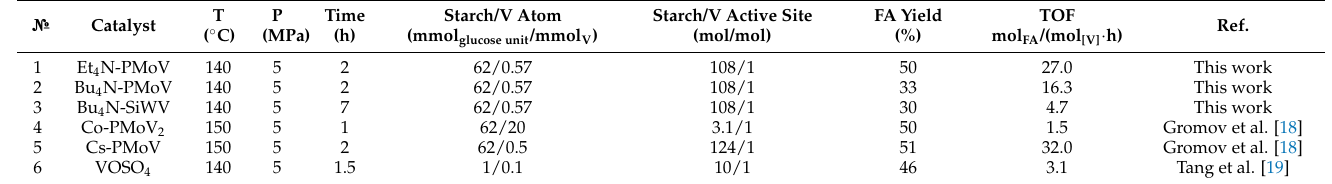
Table 4. Comparative catalytic properties of Et 4 N-PMoV catalyst in hydrolysis-oxidation of